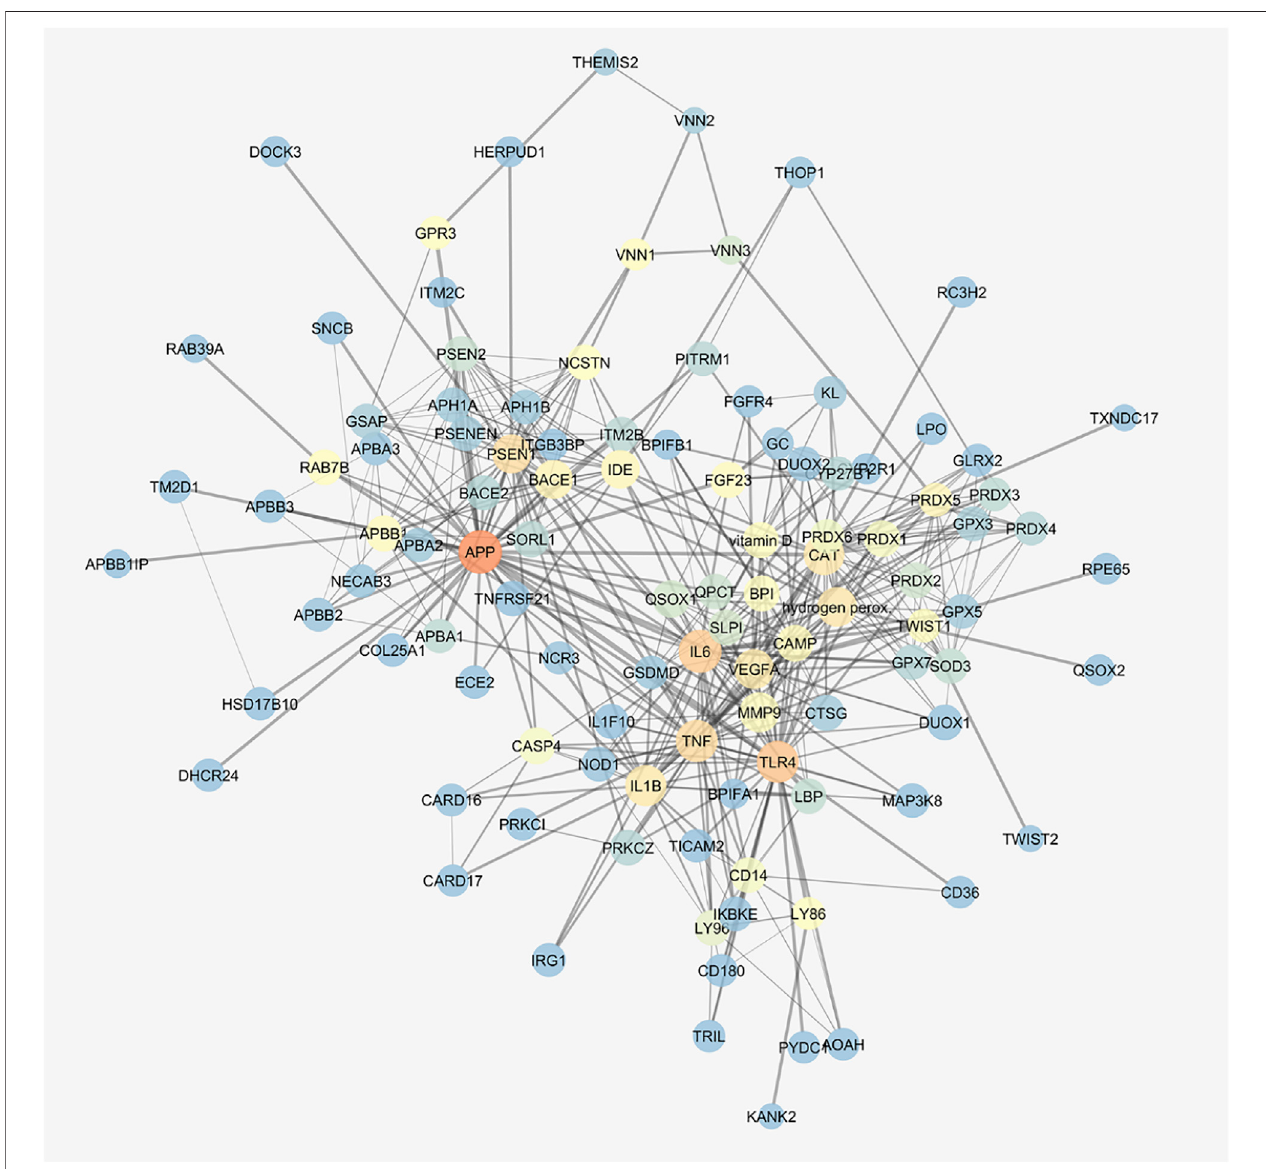
FIGURE 7 | Gene activated by amyloid β , H 2 O 2 , and LPS are connected. STITCH protein – compound network representing the in vitro models. Nodes are represented on the basis of betweenness centrality values (color scale blue < red) and closeness centrality values (node dimension); edge thickness is proportional to edge betweenness